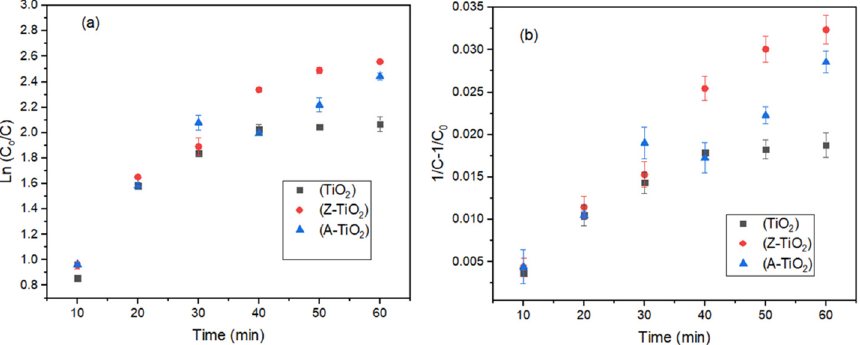
Figure 8. Photocatalytic degradation of COD (367.7 mg/L) as a function of time; ( a ) first-order and ( b ) second-order kinetic models.